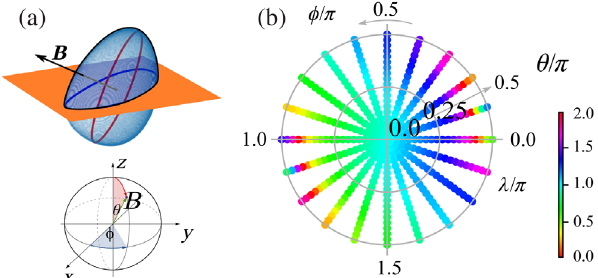
FIG. 2. (a) Fermi surface of a Weyl fermion centered on a generic wave vector in a high-symmetry plane; red circle indicates an extremal orbit that has no symmetry. (b) For a model of the Weyl fermion, we plot λ as a function of the field orientation, which we parametrize by spherical coordinates illustrated in